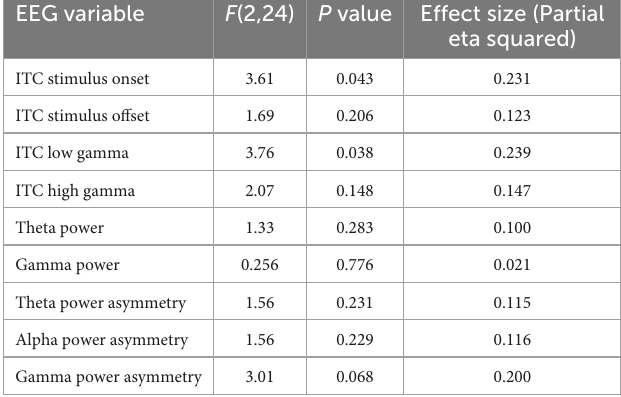
TABLE 2 Univariate results for EEG data by cluster MANCOVA. EEG variable F (2,24) P